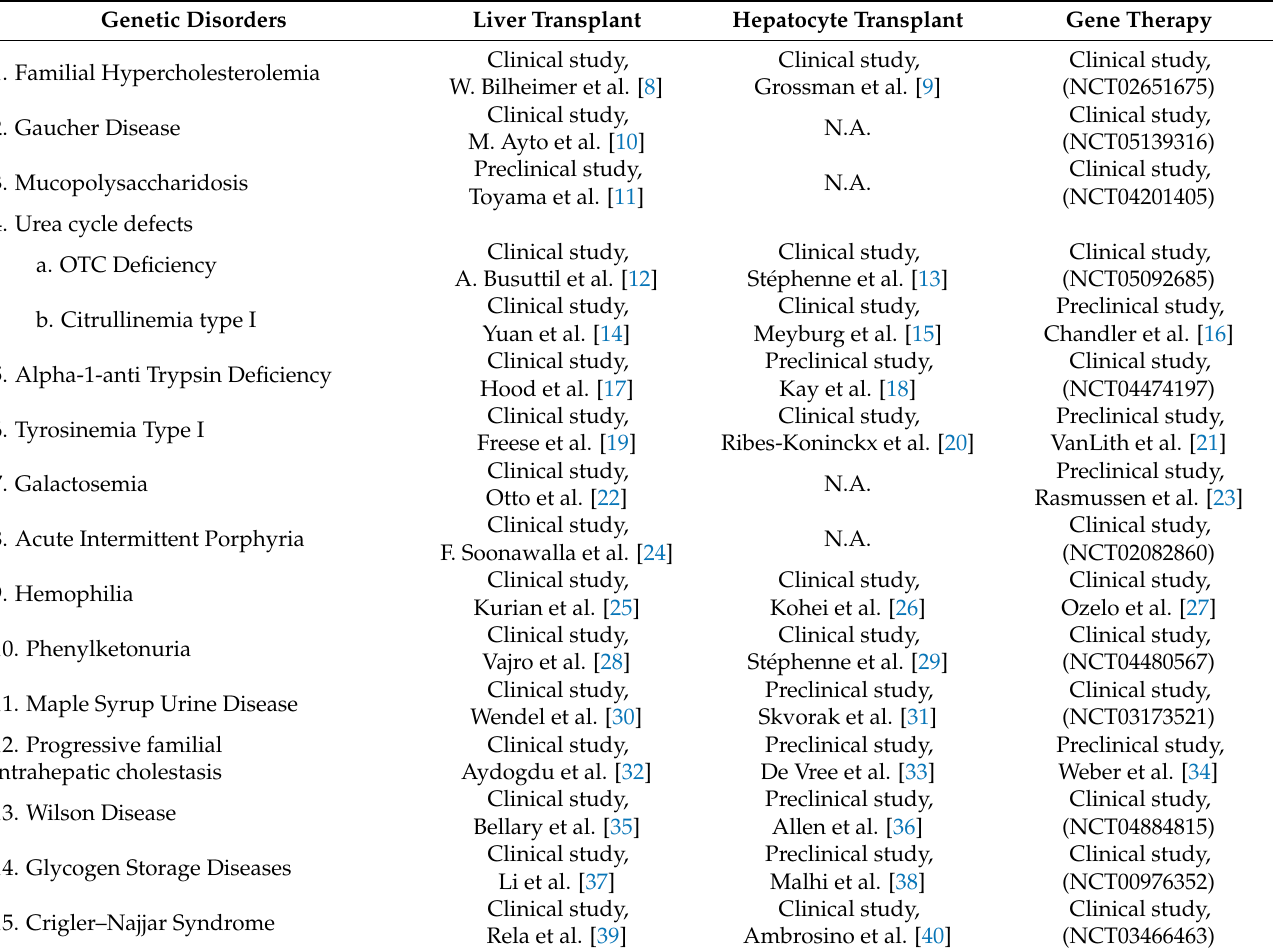
Table 1. Therapeutic options for liver genetic disorders: liver transplant, hepatocyte transplant, and gene